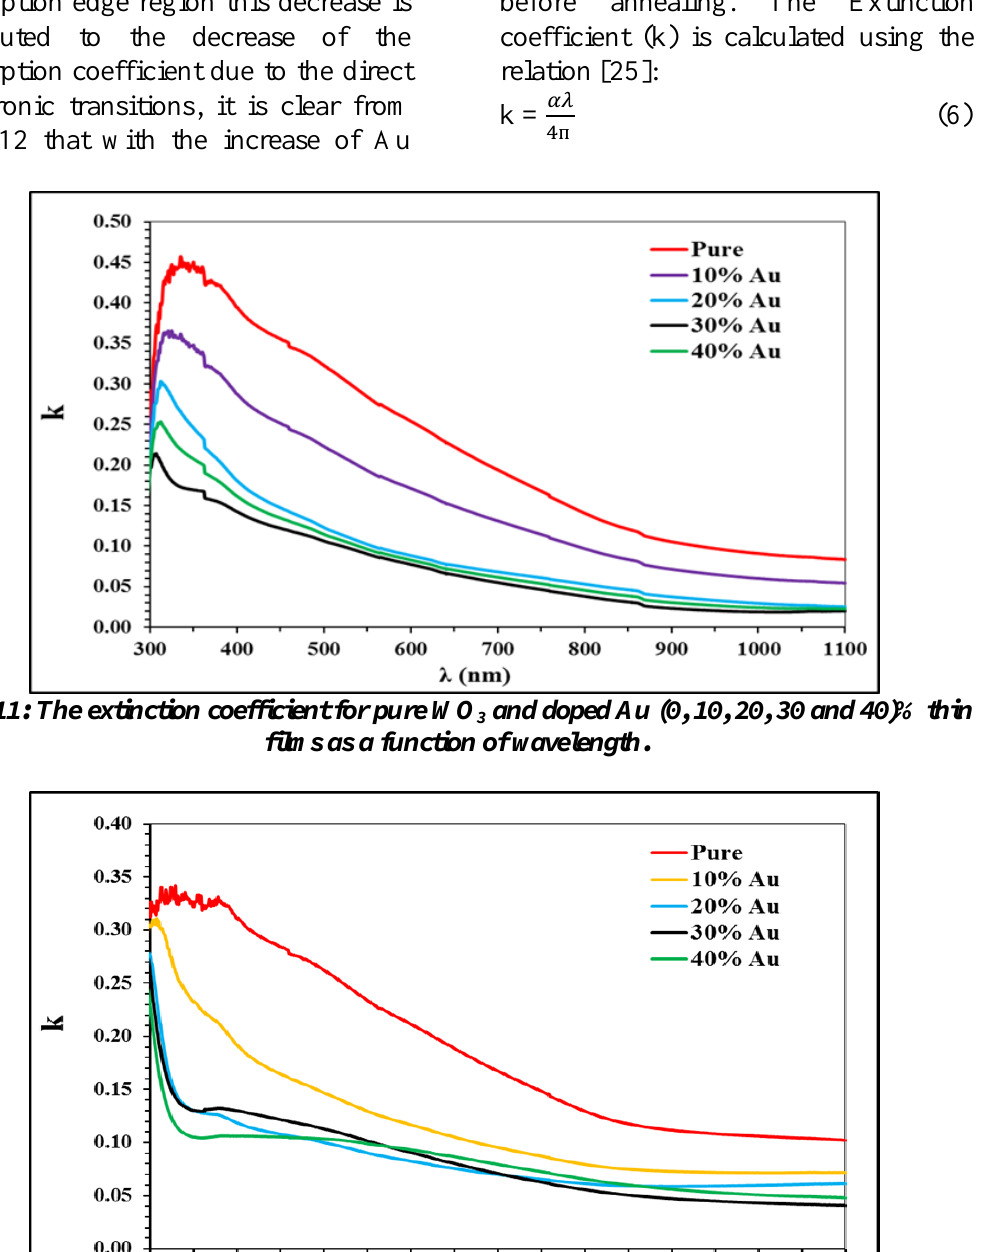
and doped Au (0, 10, 20, 30 and 40)% thin 3 = 400 a